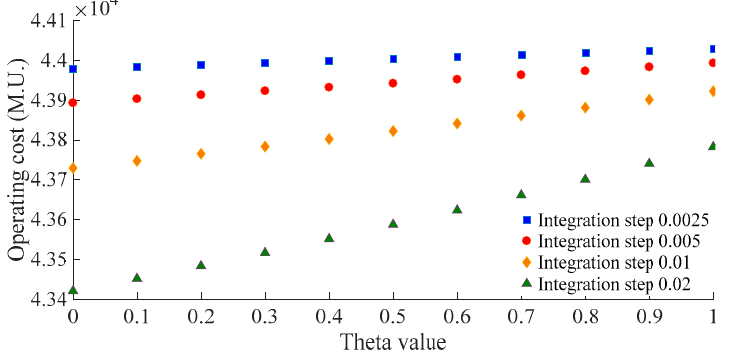
Figure 9. Results of the TSCOPF depending on the value of Theta when a short circuit is applied at bus 16.